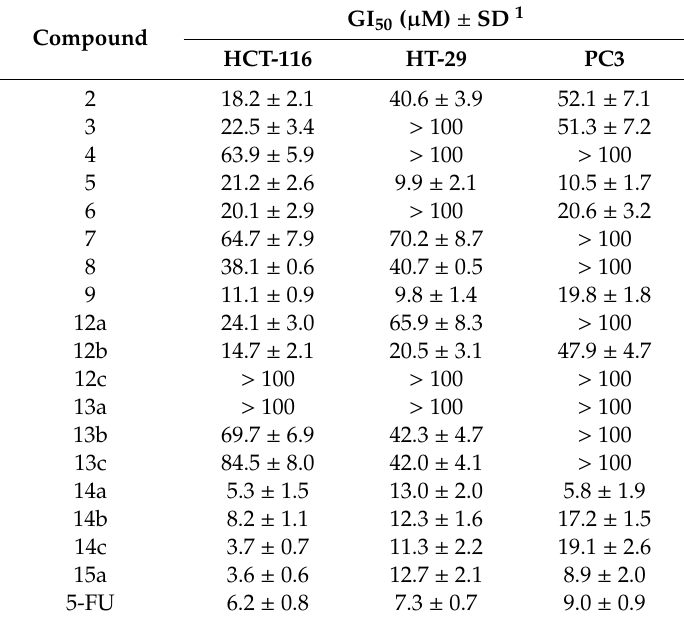
Table 3. Antiproliferative activity of bisphenol neolignans inspired by